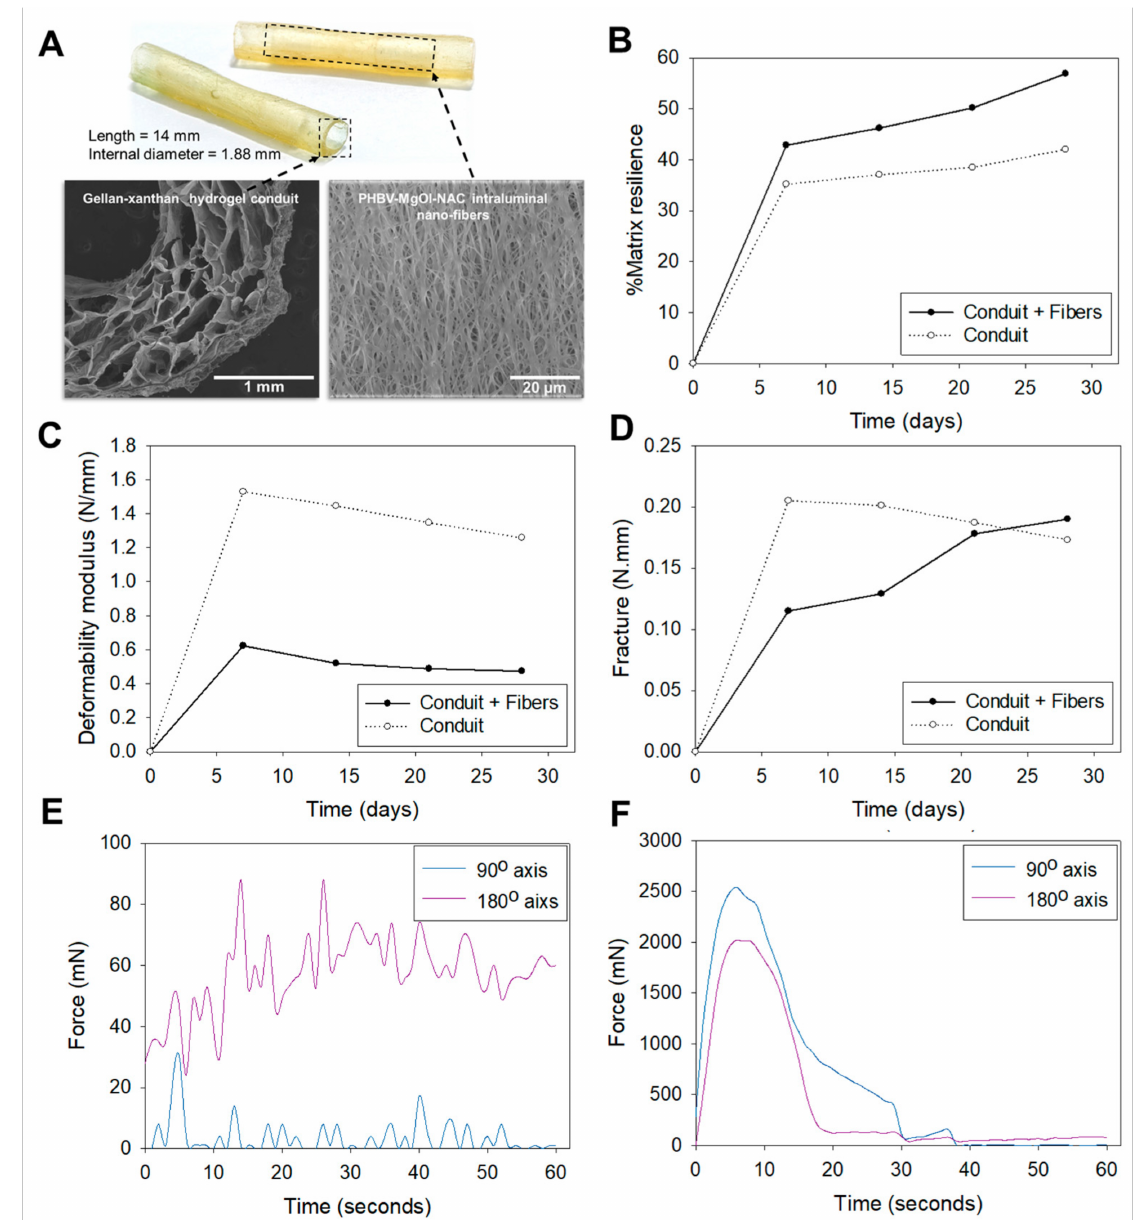
Figure 1. ( A ) Image of the BNRD comprising a gellan-xanthan hydrogel conduit with PHBV-MgOl-NAC intraluminal electrospun nanofibers. Mechanical profiles of hydrogel conduit over a 4 week study period conducted in PBS pH 7.4. ( B ) %matrix resilience, ( C ) deformability modulus, and ( D ) fracture. Biaxial mechanical profiles of hydrogel conduit and electrospun fibers are in dry state. ( E ) Tensile analysis of electrospun fibers and ( F ) tensile analysis of hydrogel